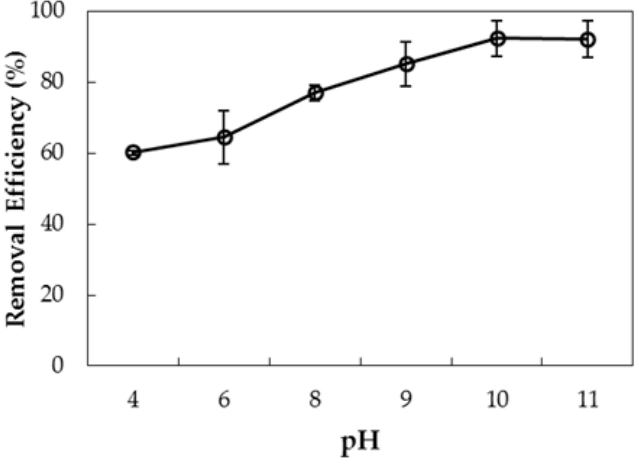
Figure 13. Influence of pH on removal of AMX using PMS. Error bars show standard deviations of three replicates.